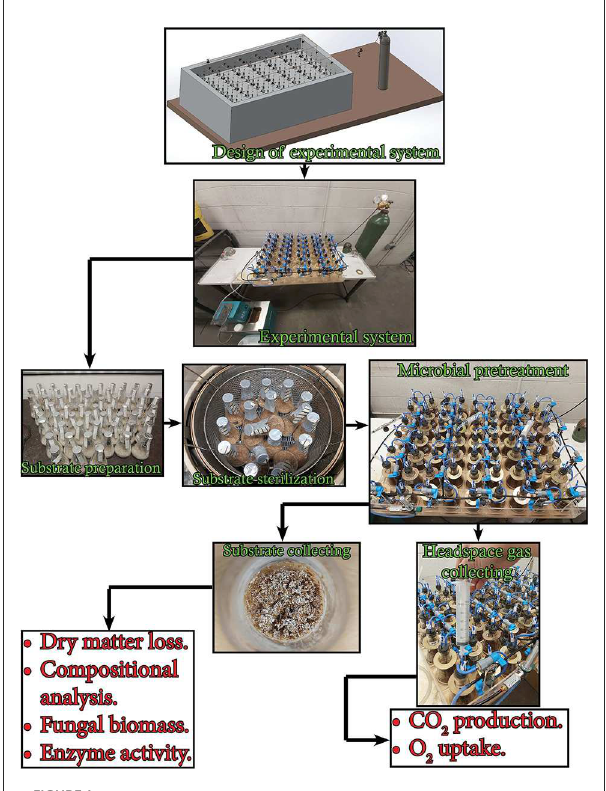
FIGURE1 Flow diagram of the experiment in this study indicating the measurements